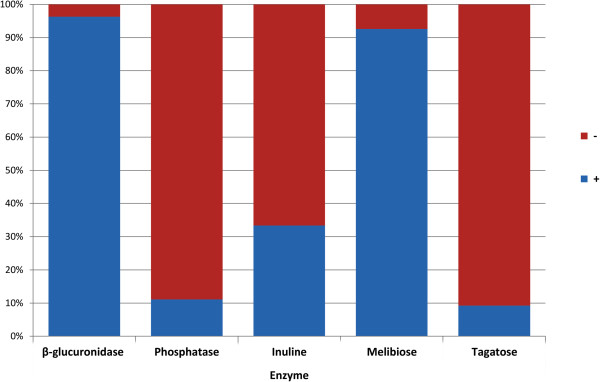
Distribution of enzymes selected for biotyping (graphs marked in blue).